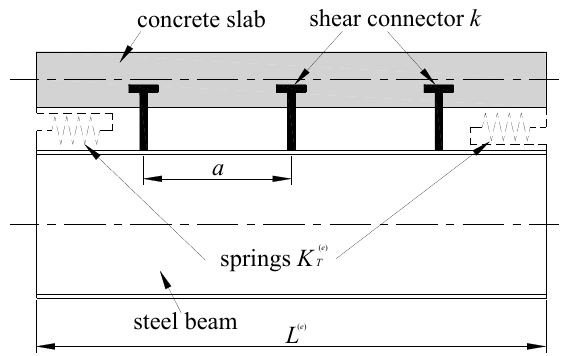
Figure 1. Springs for shear connectors.